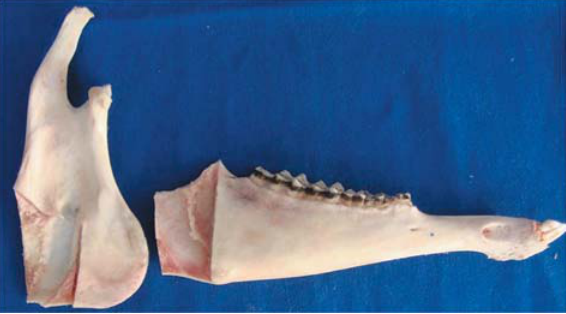
Figure 2- Sagittal osteotomy used to separate the